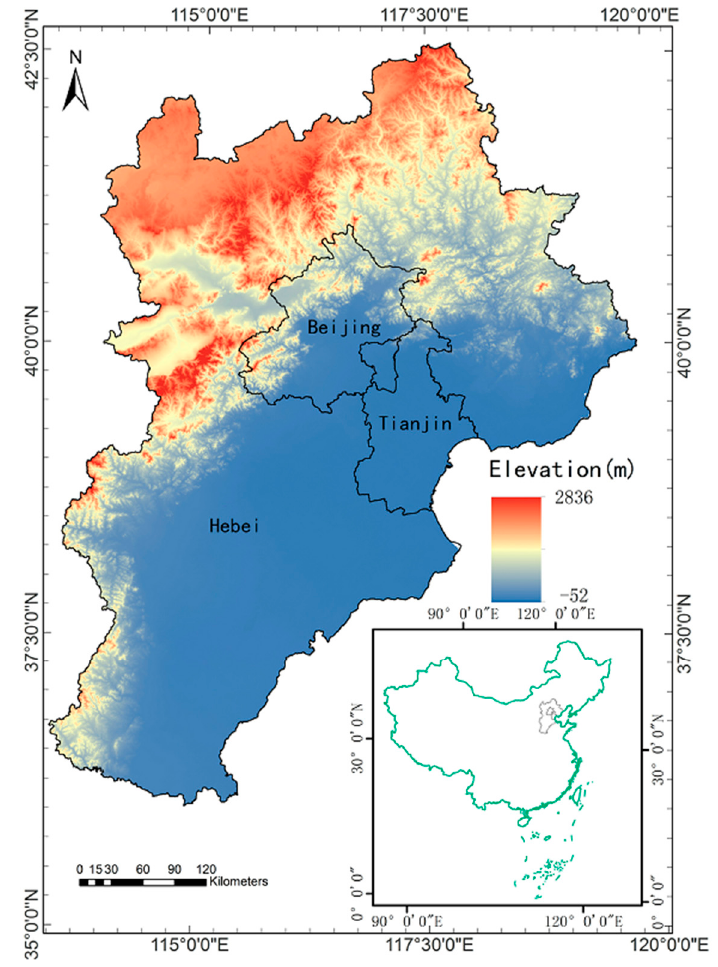
Figure 1. The elevation map of the experimental area and its location in